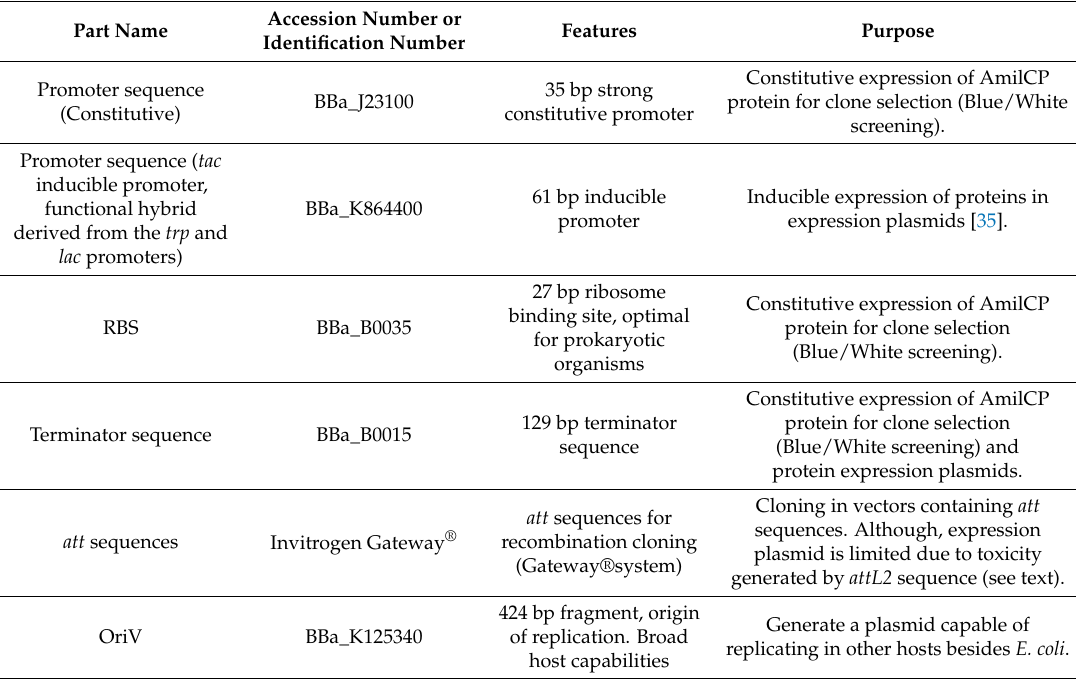
Table 2. Parts used to generate the plasmids in this study.